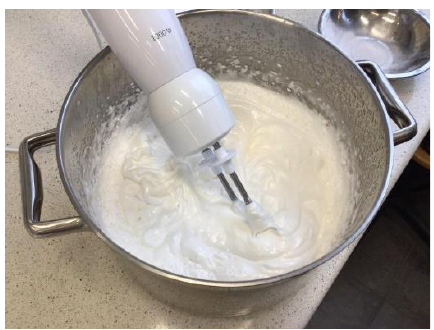
Figure 2. Meringue mass based on aquafaba (photo by Joanna Stasiak).